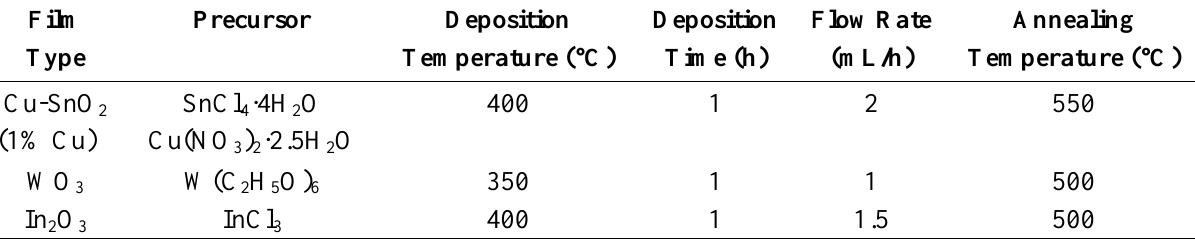
Table 1. Experimental parameters used for the film